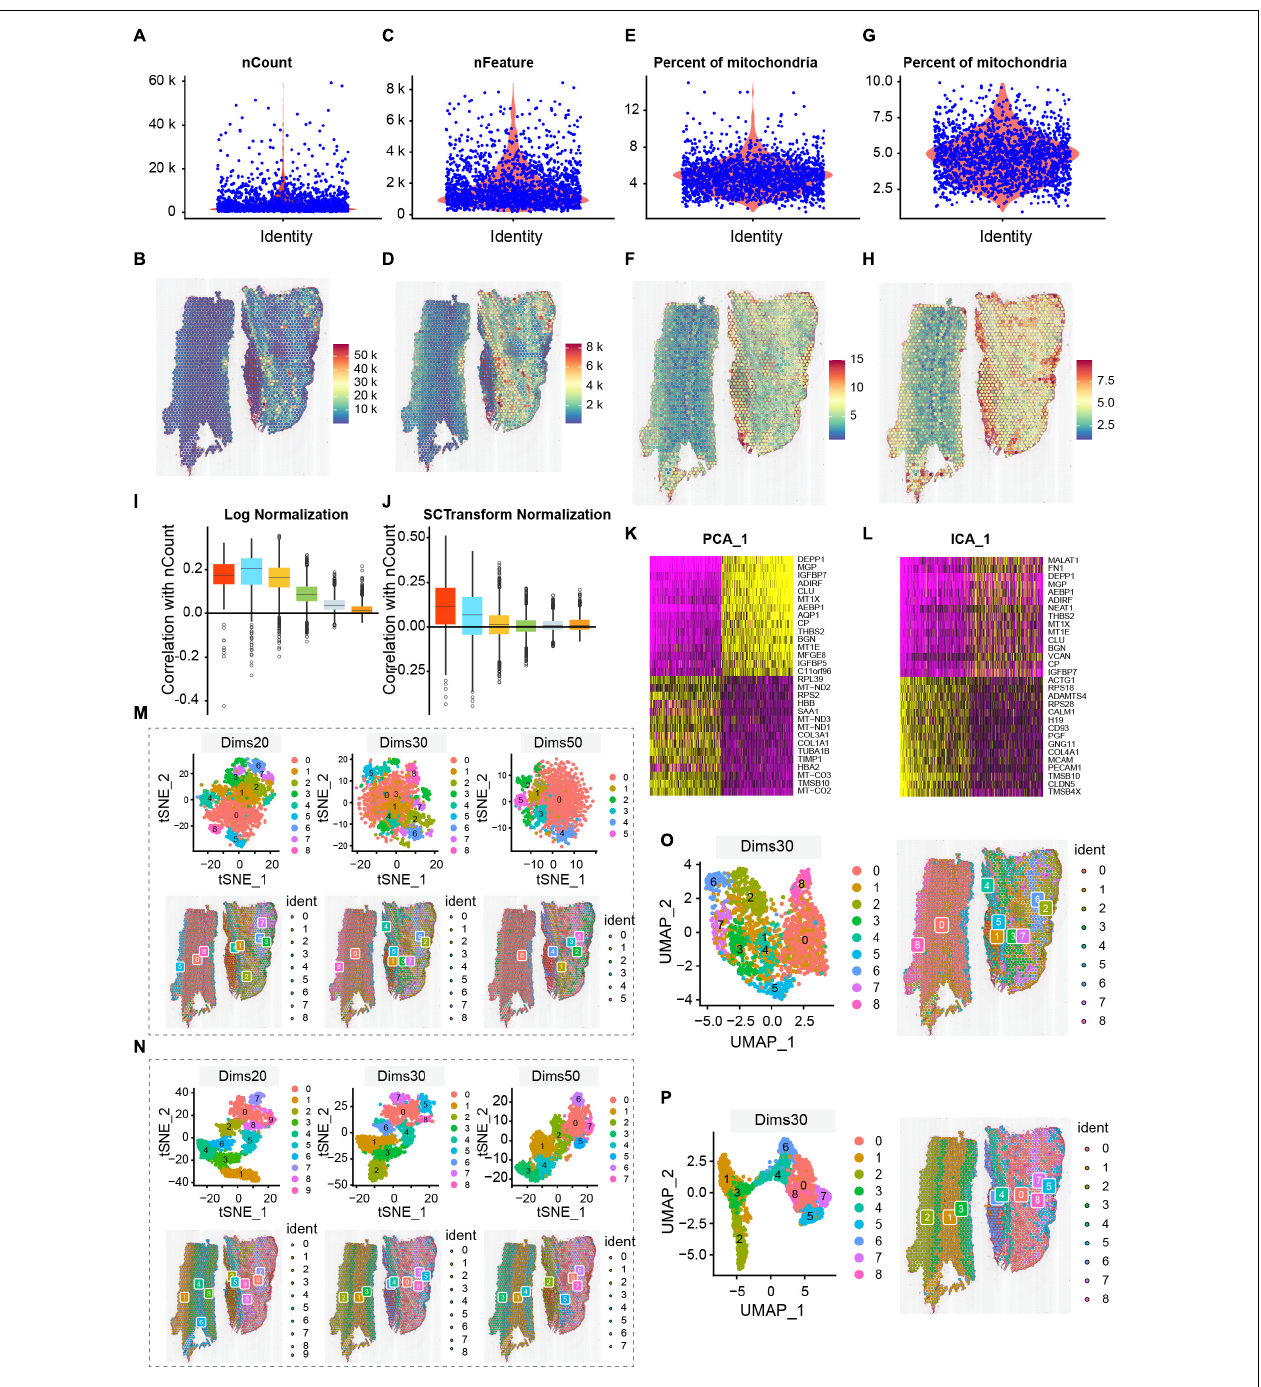
FIGURE 2 | Quality control and ST data analysis. (A,B) The number of nCount_RNA is range of 10,000–20,000, with the maximum not exceeding 60,000, and spatial UMIs distribution is concentrated in the aortic of tunica media and external. (C,D) The number of genes is mostly between 1,000 and 7,500. Combined with the distribution of UMIs data, the region with a high number of genes also had a high number of UMIs. (E,F) The percentage of mitochondria is low, between 1 and 12%. Correspondingly, the distribution of spatial UMIs in the tunica media and external is also rare. (G,H) Cells with > 10% mitochondrial reads are filtered, and display distribution of spatial UMIs. The colors from blue to red represented increasing number of expression. (I,J) Comparison of normalization methods (log and SCTransform normalization), the SCTransform normalization is superior to Log Normalization. (K,L) Comparison of compositional analysis (PCA and ICA). (M–P) Comparison of dimensionality reduction and clustering methods, among them, (M,O) are under the ICA condition, the distribution of t-SNE (dims 20, 30, 50) and UMAP (dims 30); (N,P) are under the PCA condition, the distribution of t-SNE (dims 20, 30, 50) and UMAP (dims 30). Overall, PCA dims 30 combined with UMAP dimensionality reduction cluster analysis is an appropriate method. The Clusters are labeled using different